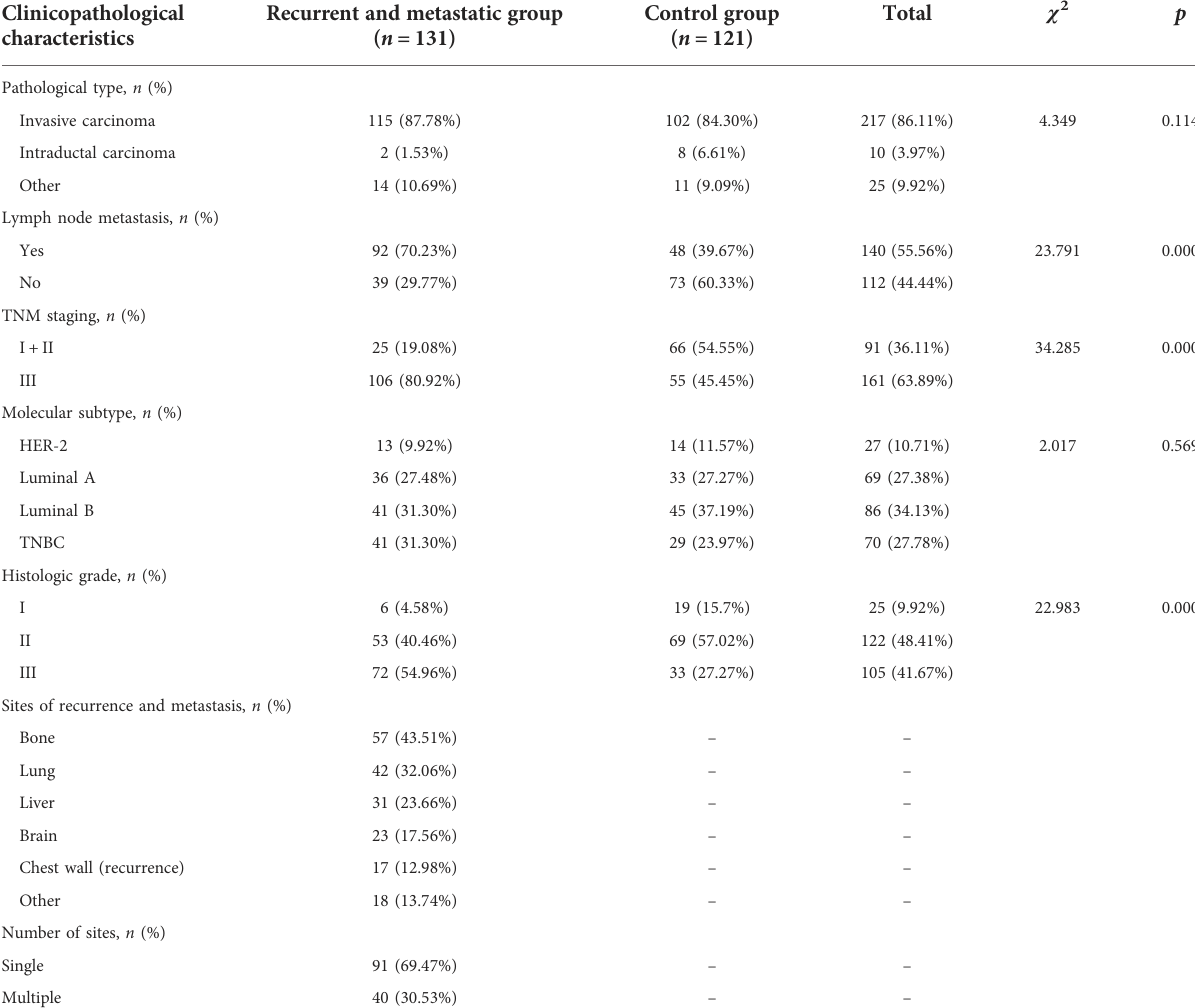
TABLE 2 Clinicopathological characteristics of the two groups. Clinicopathological